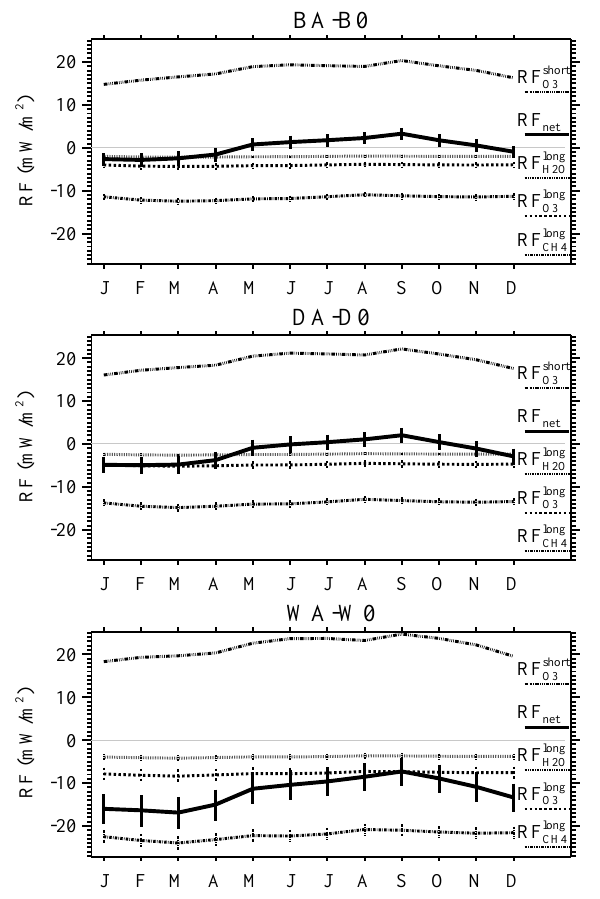
Table D1. Radiative forcing (in mWm − 2 ) for aviation NO x